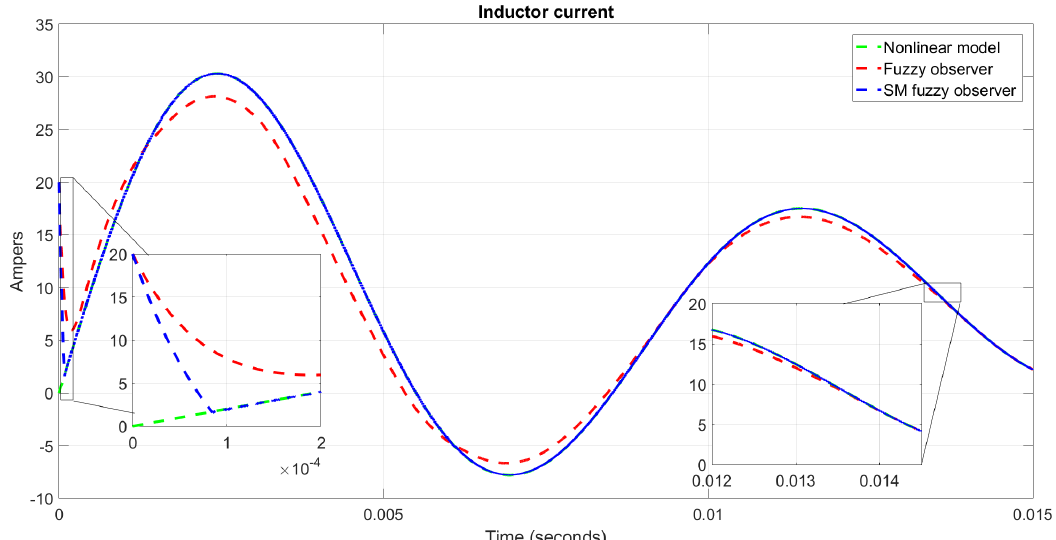
Figure 14. Current transient in v C with different conditions, (ˆ i L ( 0 ) = 0 A, ˆ v C ( 0 ) = 20 A).